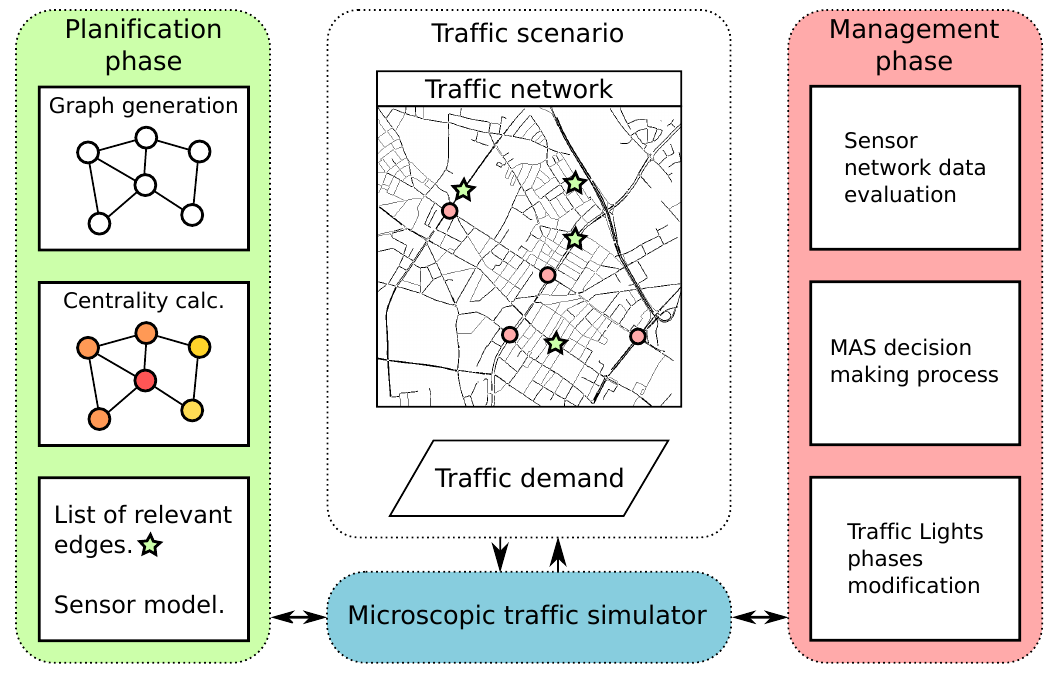
Figure 1. Overview of the proposed